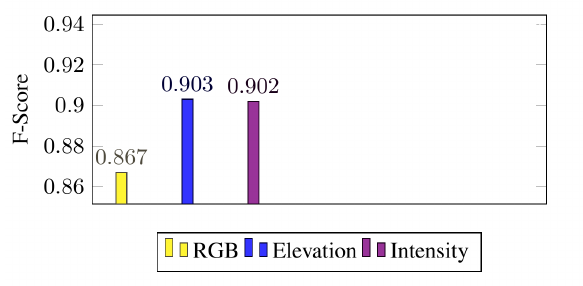
Figure 10. F-Scores for the fine-tuning of the